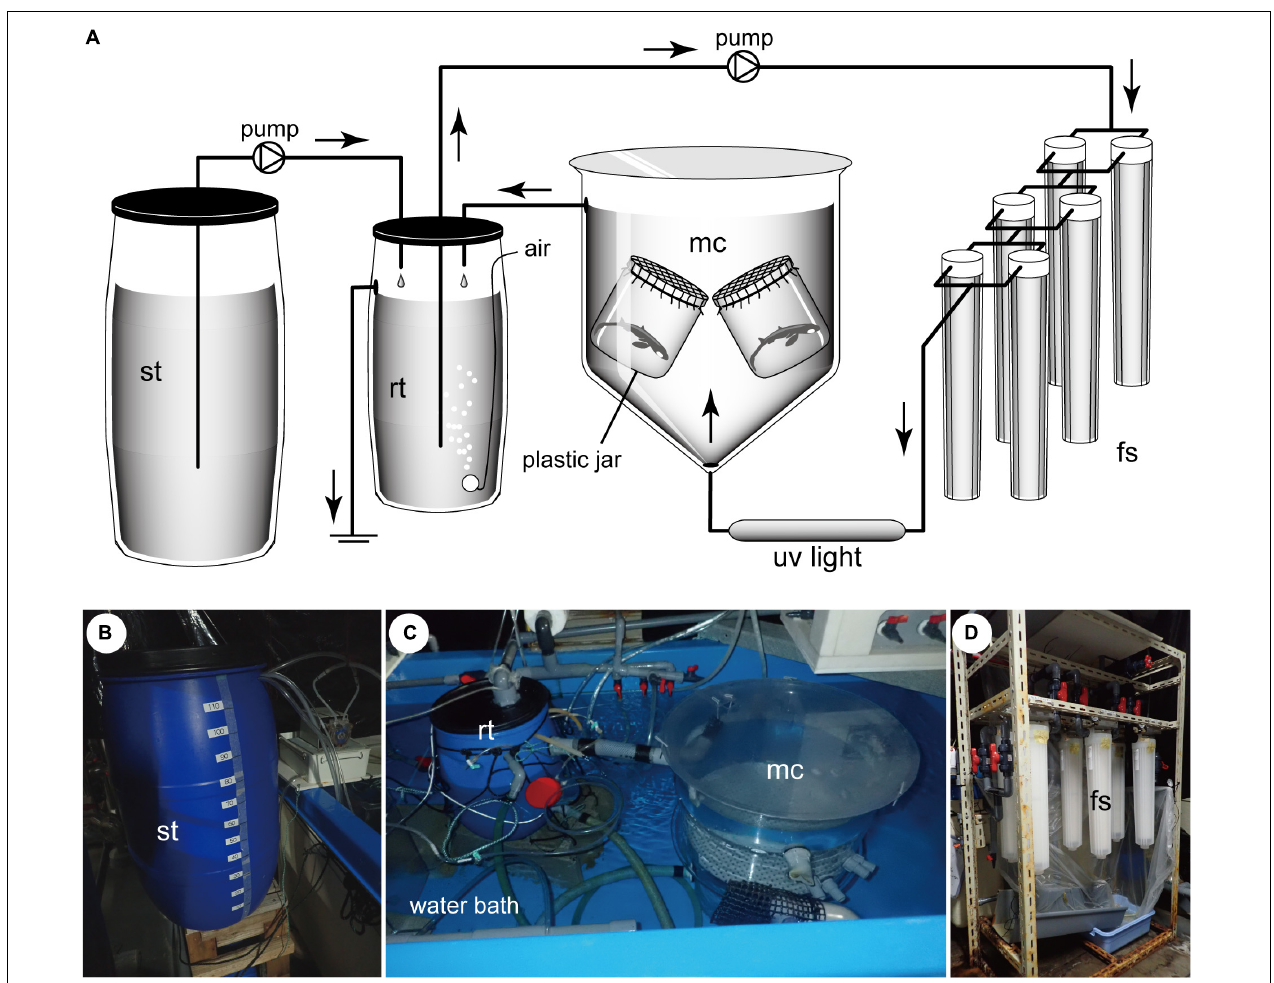
FIGURE 1 | (A) The circuits and components of the artificial uterus developed in this study, consisting of a main chamber (mc), reserve tank (rt), filtering system (fs), and supply tank (st). (B–D) Photographs of components of the artificial uterus shown in (A) . Main chamber and reserve tank are placed in a water bath to maintain an internal temperature of 13 ◦ C.